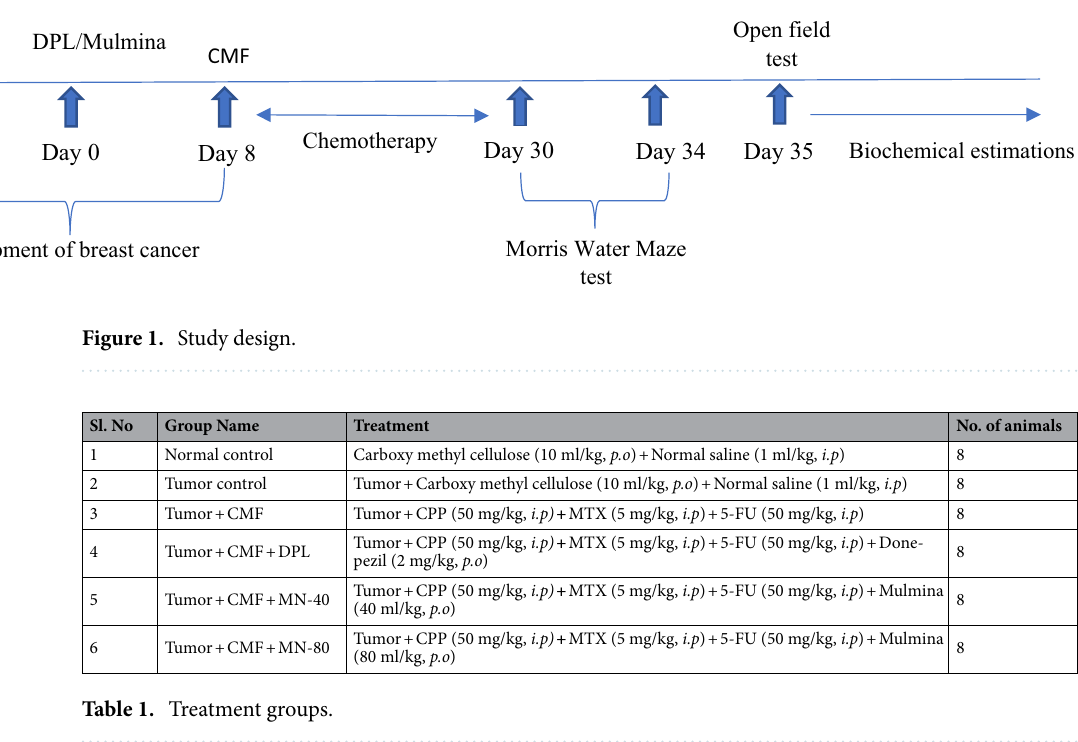
(Table 1) and drug treatments were given accordingly (Fig: 2). Animal doses of Mulmina were selected based on human equivalent dose as per FDA human equivalent dose conversion table. 0.25% Carboxymethylcellulose (CMC) was used as the vehicle for suspending Donepezil and normal saline was used as the vehicle for dissolving Cyclophosphamide.